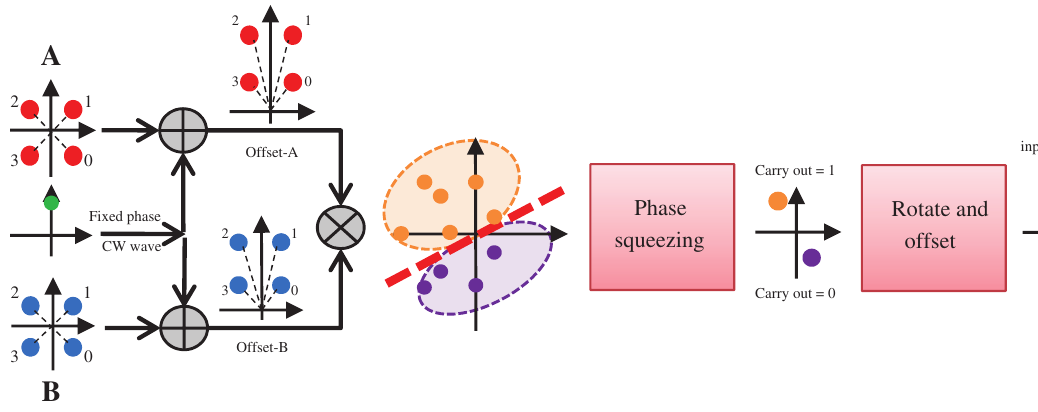
Figure 20: Generating the carry of the sum of QPSK symbols (A) and (B) via half-sum and phase